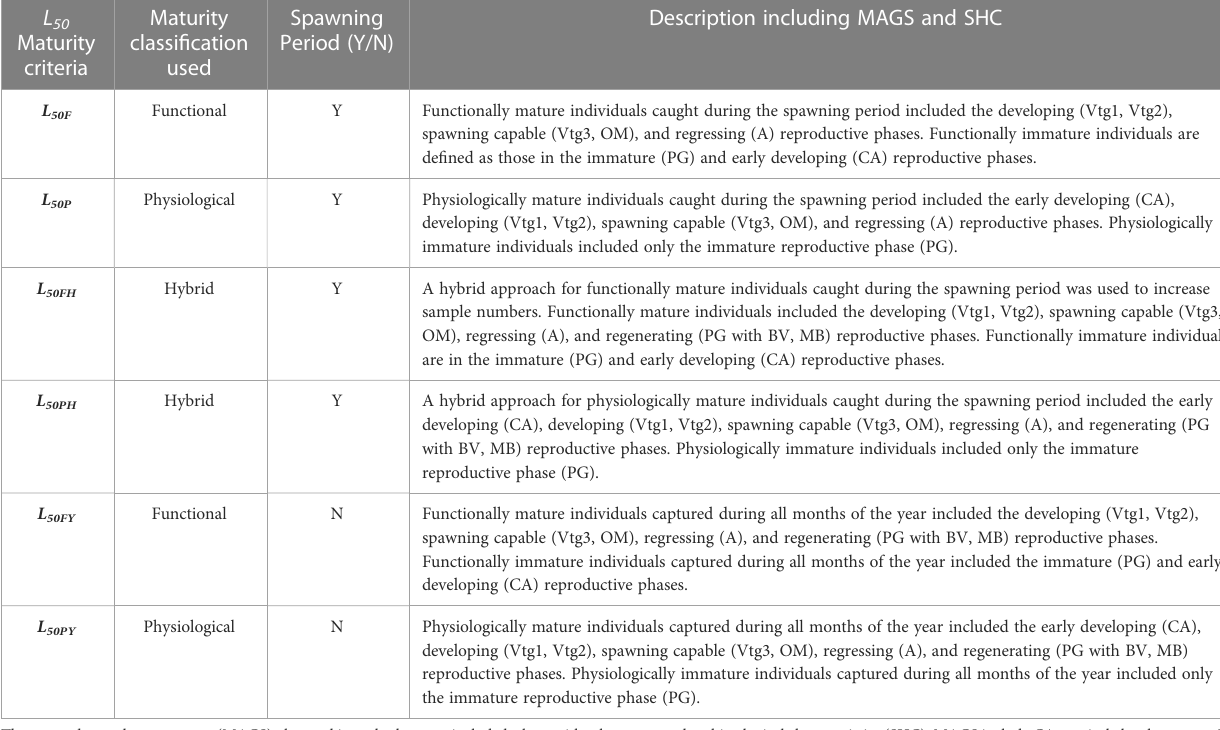
TABLE 1 Six different combinations of female reproductive phases and spawning periods were assessed in accordance with de fi nitions of functional and physiological maturity to estimate length-speci fi c sexual maturity using a logistic